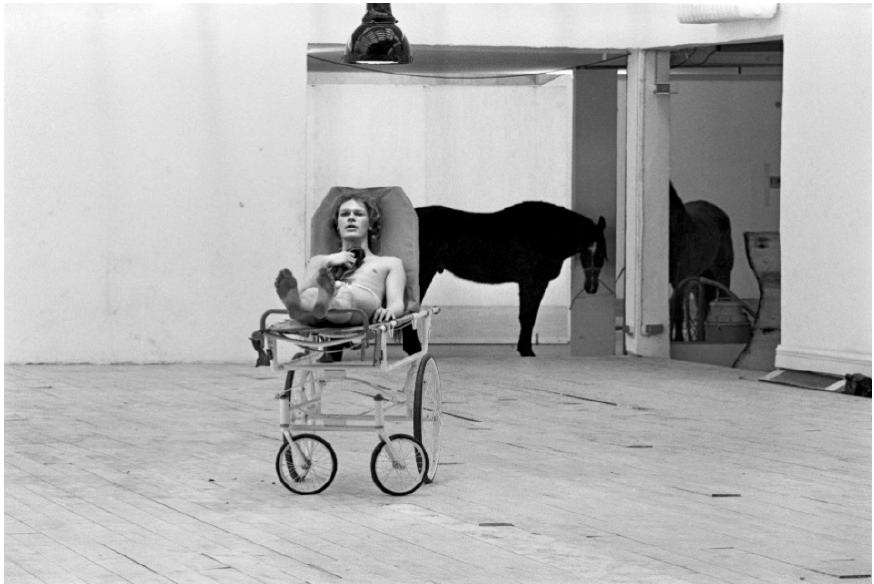
Figure 1. Dionysus on a hospital gurney, in Die Bakchen directed by Klaus Michael Grüber for the Berlin Schaubühne, 1974. Deutsches Theatermuseum München, © Helga